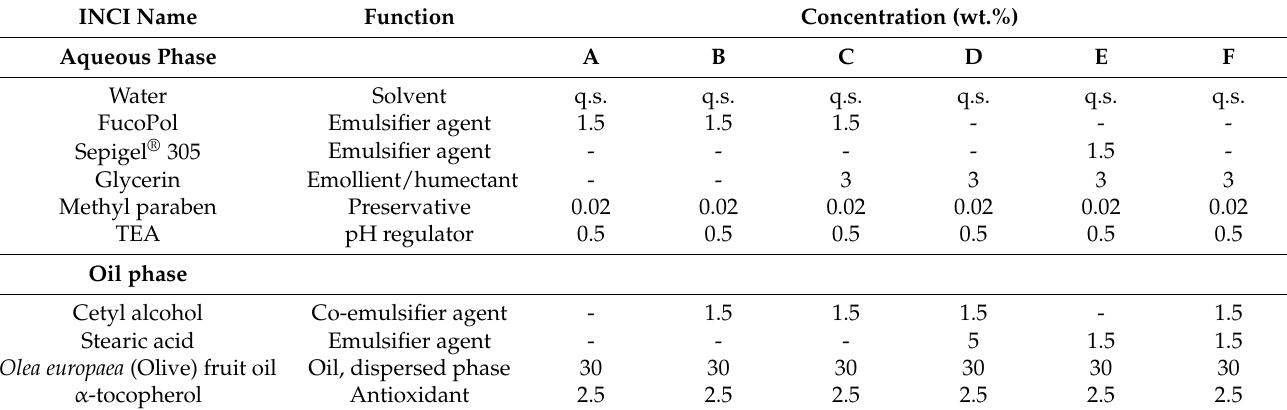
Table 6. Cosmetic formulation composition (wt.%). q.s.–quantity